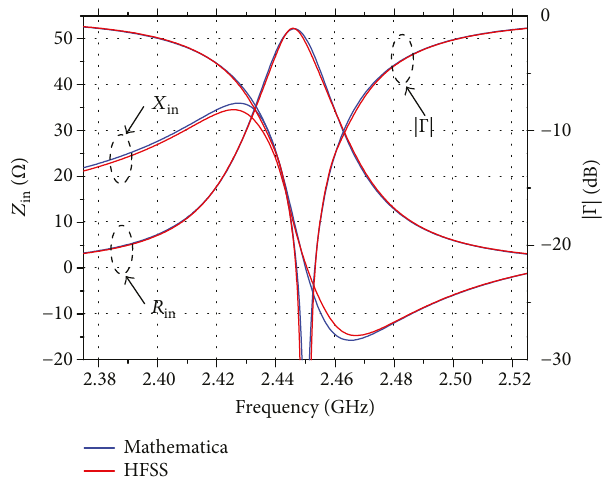
Figure 17: Input impedance and re fl ection coe ffi cient module. Table 7: Antenna dimensions for null reactance design. ( W = 140 mm ). 140mm ; W y